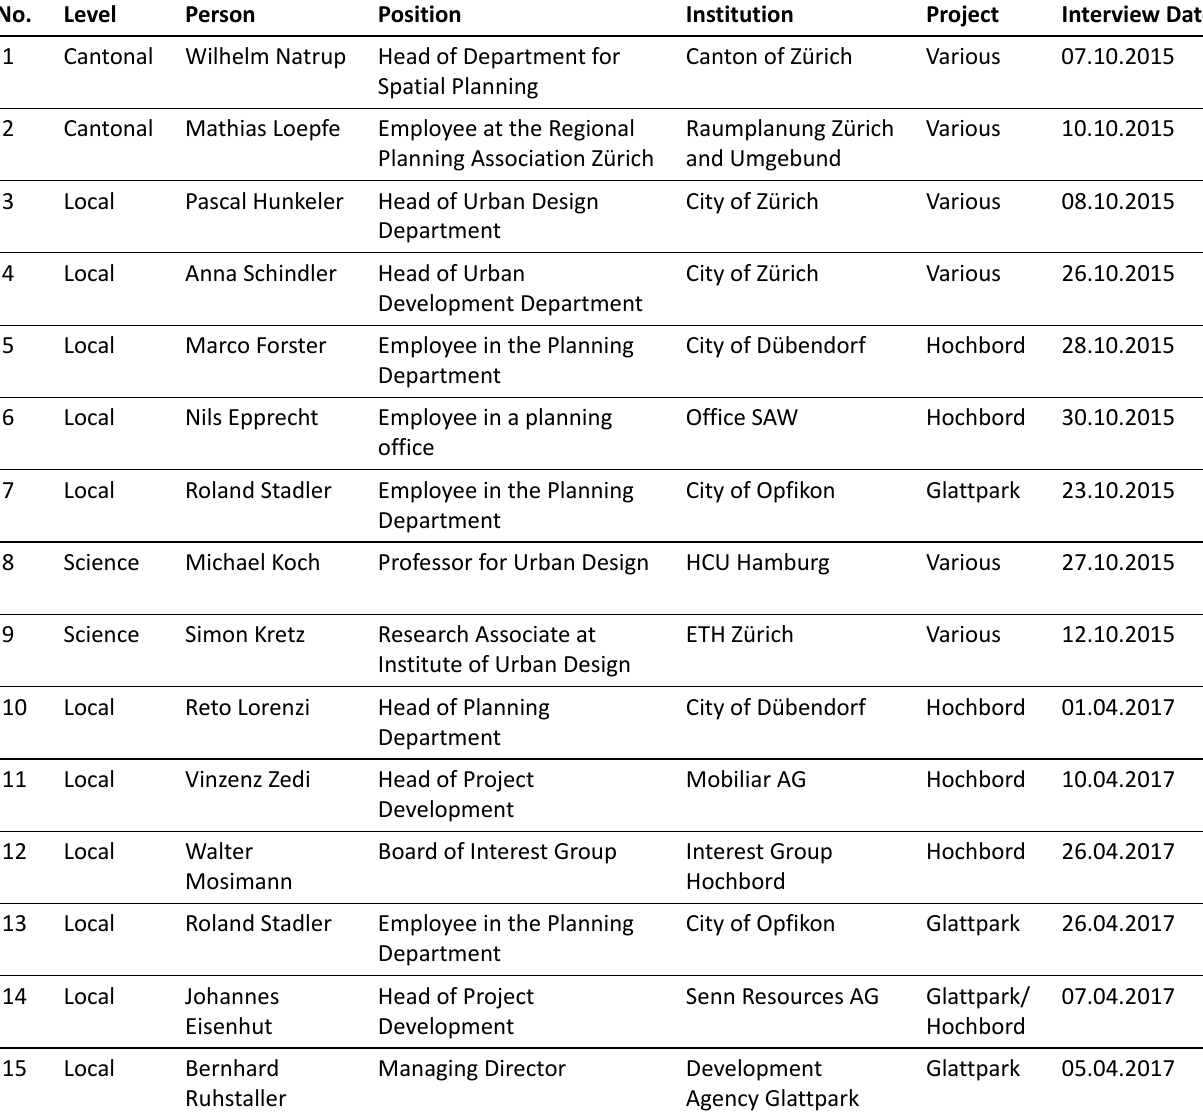
Table 1. List of interview partners.